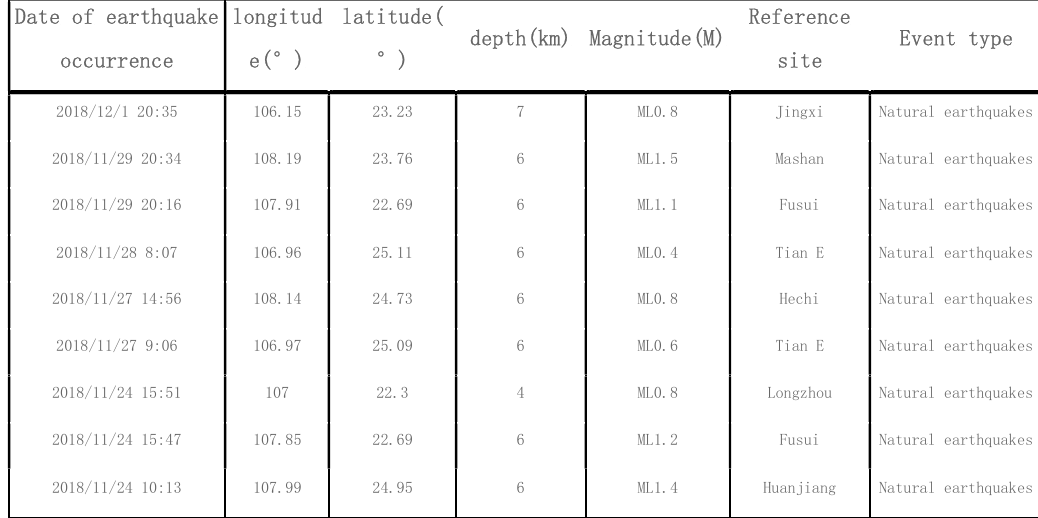
Table 1 earthquake occurred in guangxi region from November 8, 2018 to December 8,